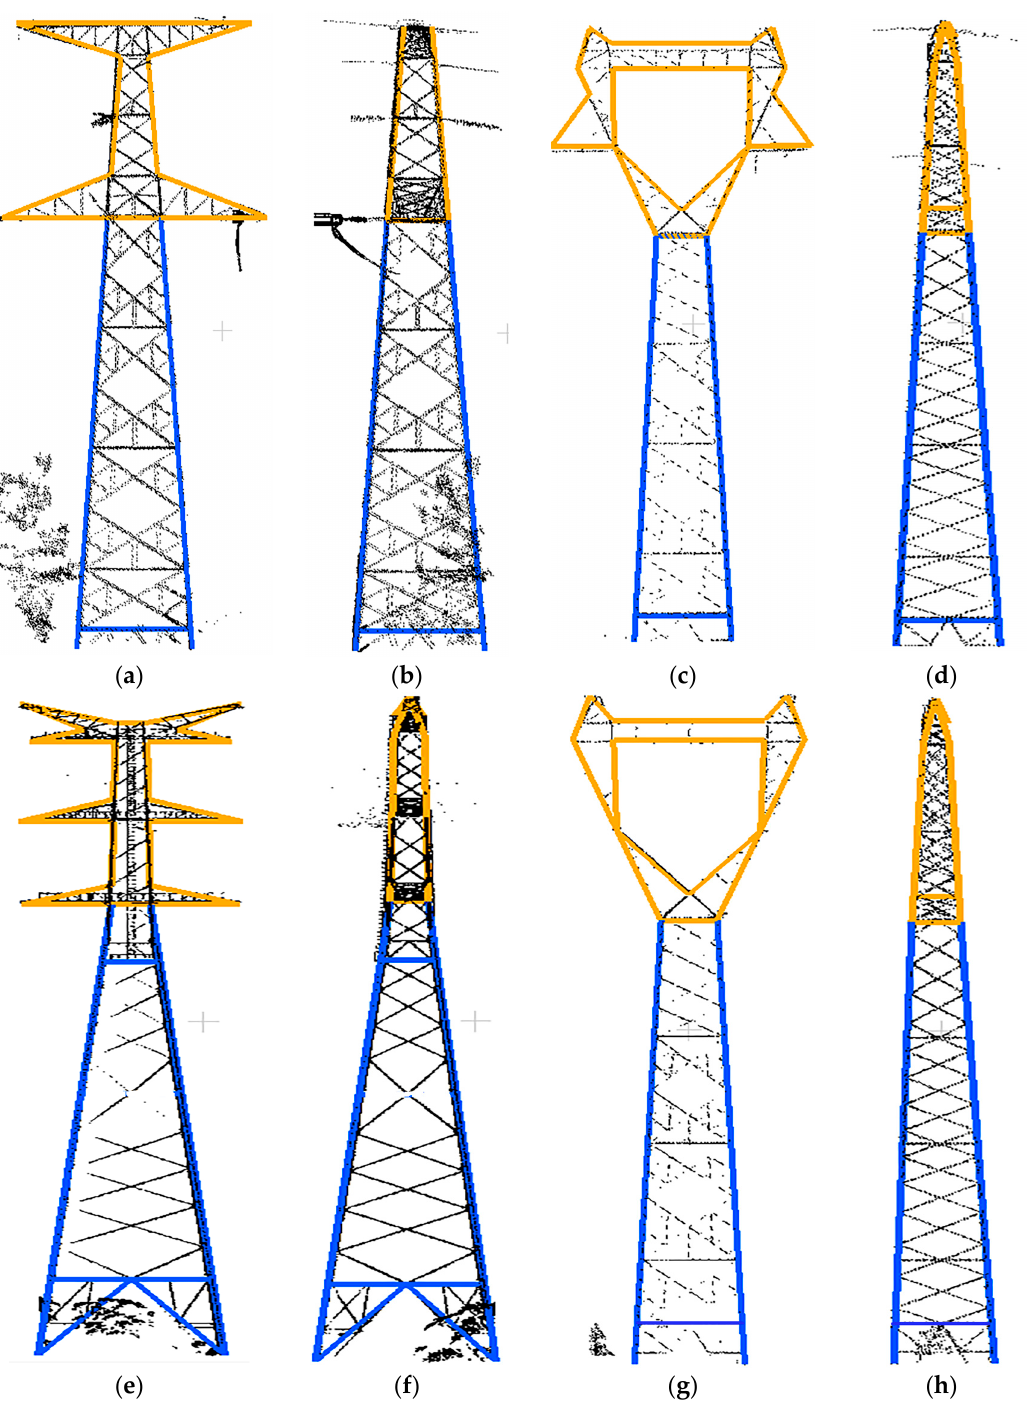
Figure 13. Four typical pylon reconstruction results. The pylon body reconstruction results are colored in blue, while the pylon head reconstruction results are colored in yellow. ( a , b ), ( c , d ), ( e , f ) and ( g , h ) are the reconstructed model of Type 1, Type 2, Type 3 and Type 4, respectively.